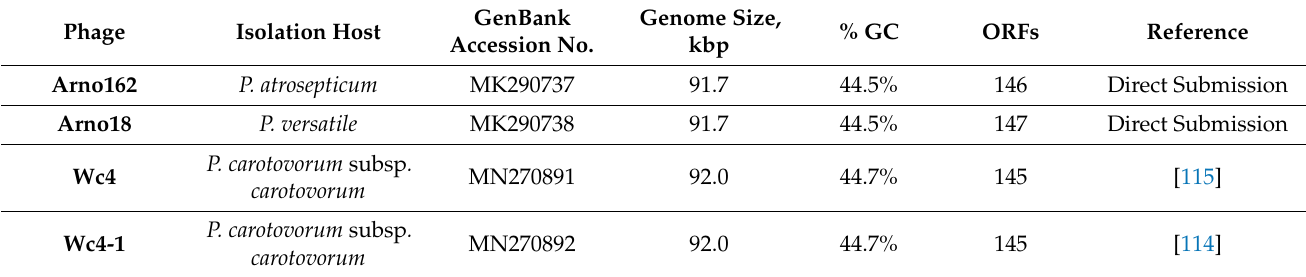
Table 3. Genomic properties of Ounavirinae bacteriophages infecting